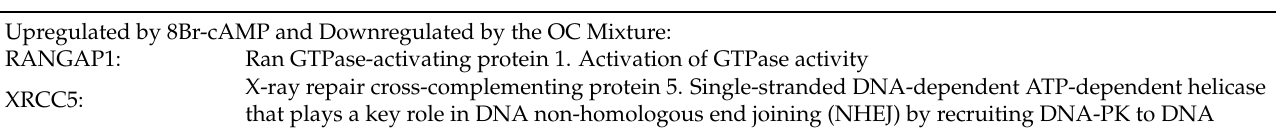
Table 4. Main function of proteins identified in Sample 1 and modulated by the OC mixture (Figure